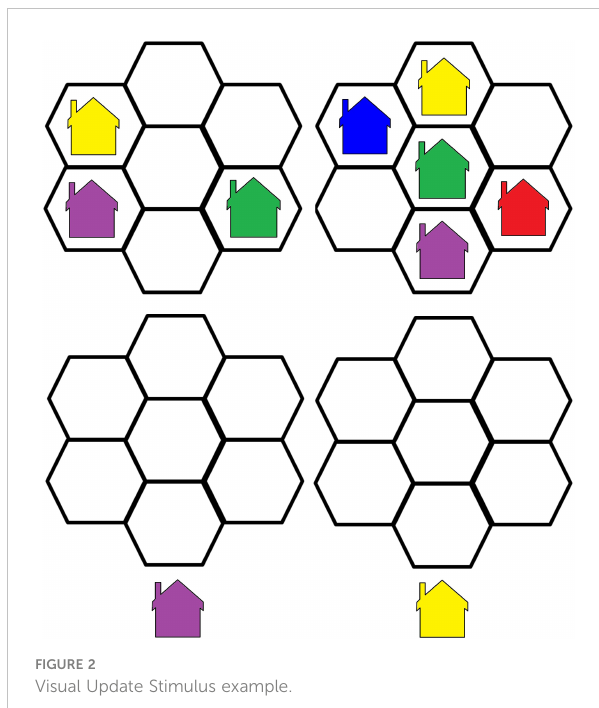
FIGURE 2 Visual Update Stimulus